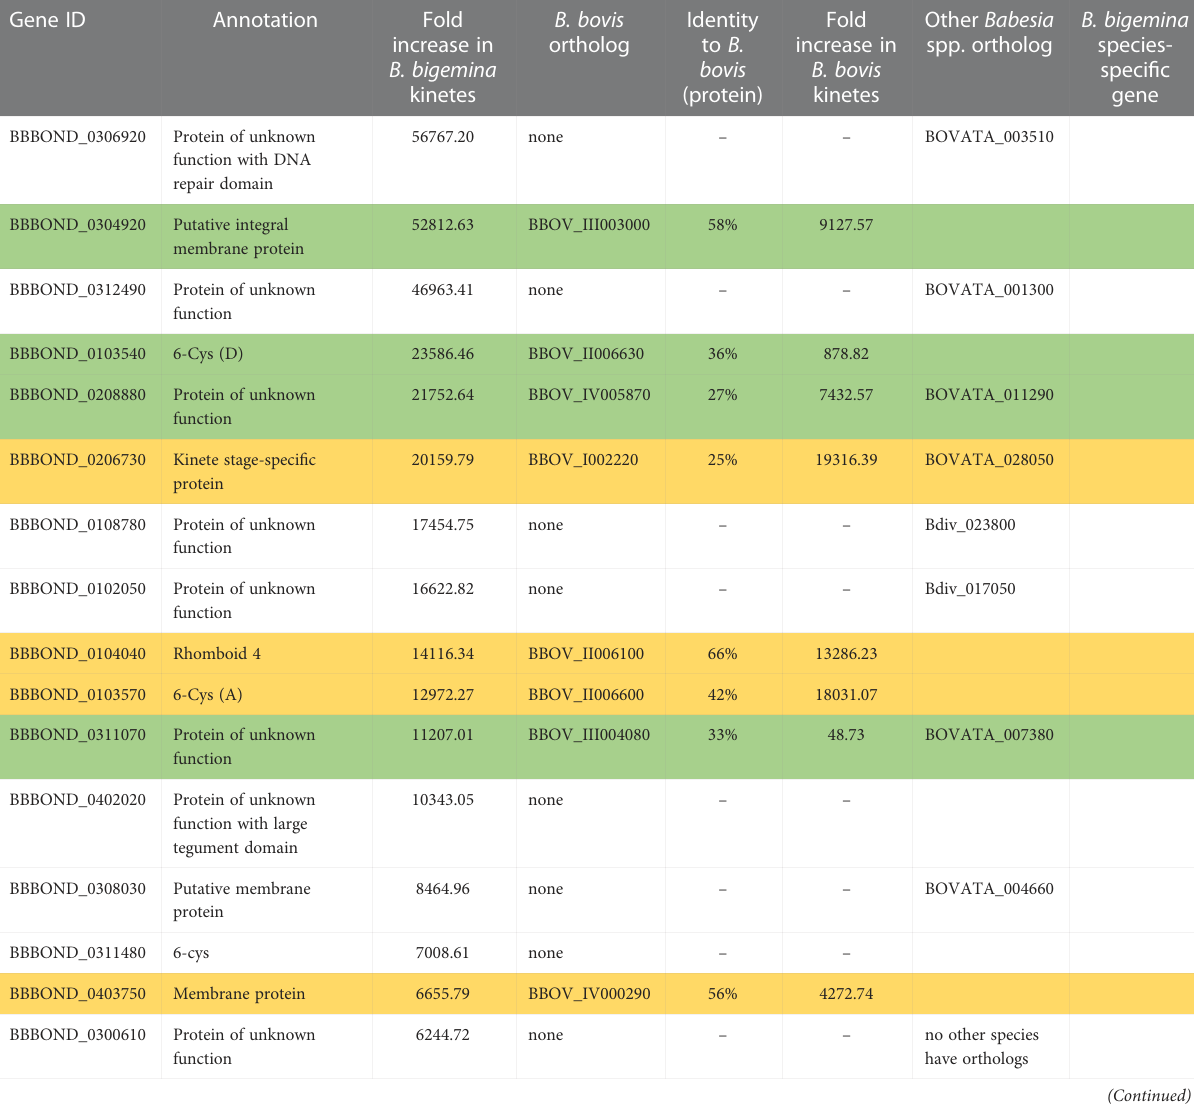
TABLE 2 Differential expression of genes highly expressed in B. bigemina kinetes. Orthologs of these genes in B. bovis (BBOV), B. ovata (BOVATA) and B. divergens (Bdiv) were found by synteny using PiroplasmaDB. Gene